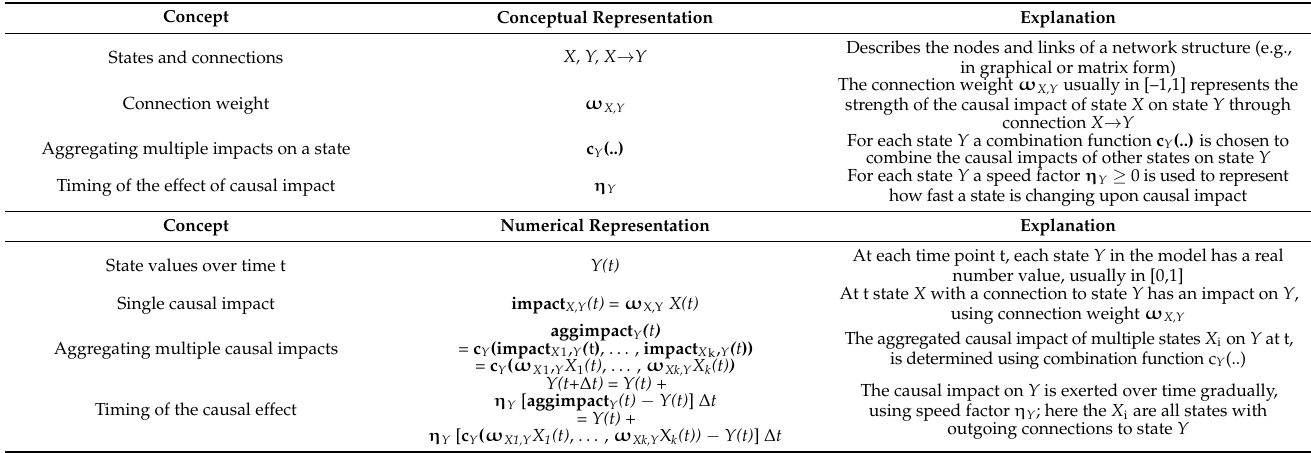
Table 2. Basics of a temporal-causal network